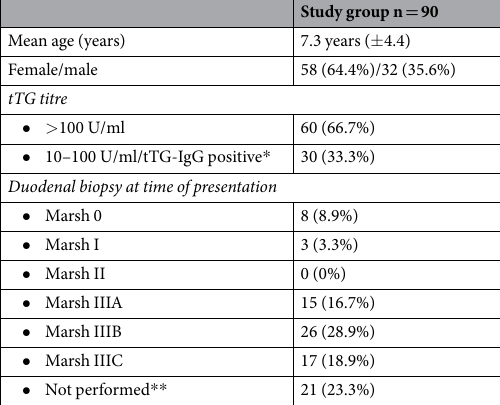
Table 1. Baseline characteristics of the study group. * tTG-IgG titres were measured in three patients because